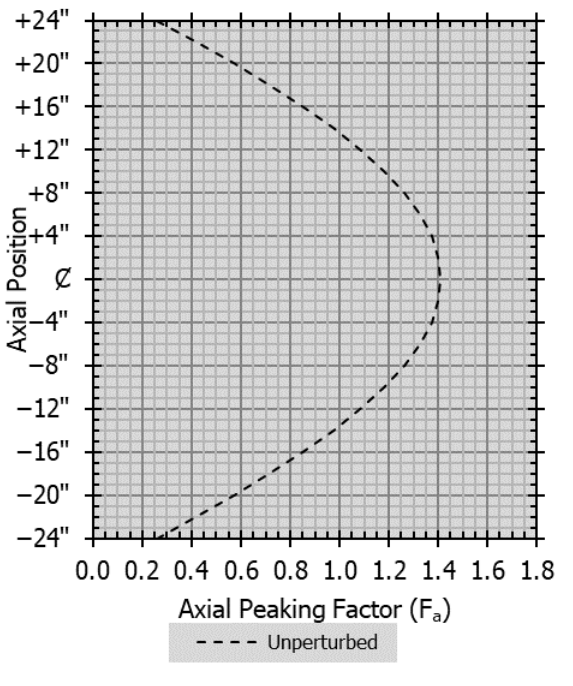
Figure 2. Unperturbed Axial